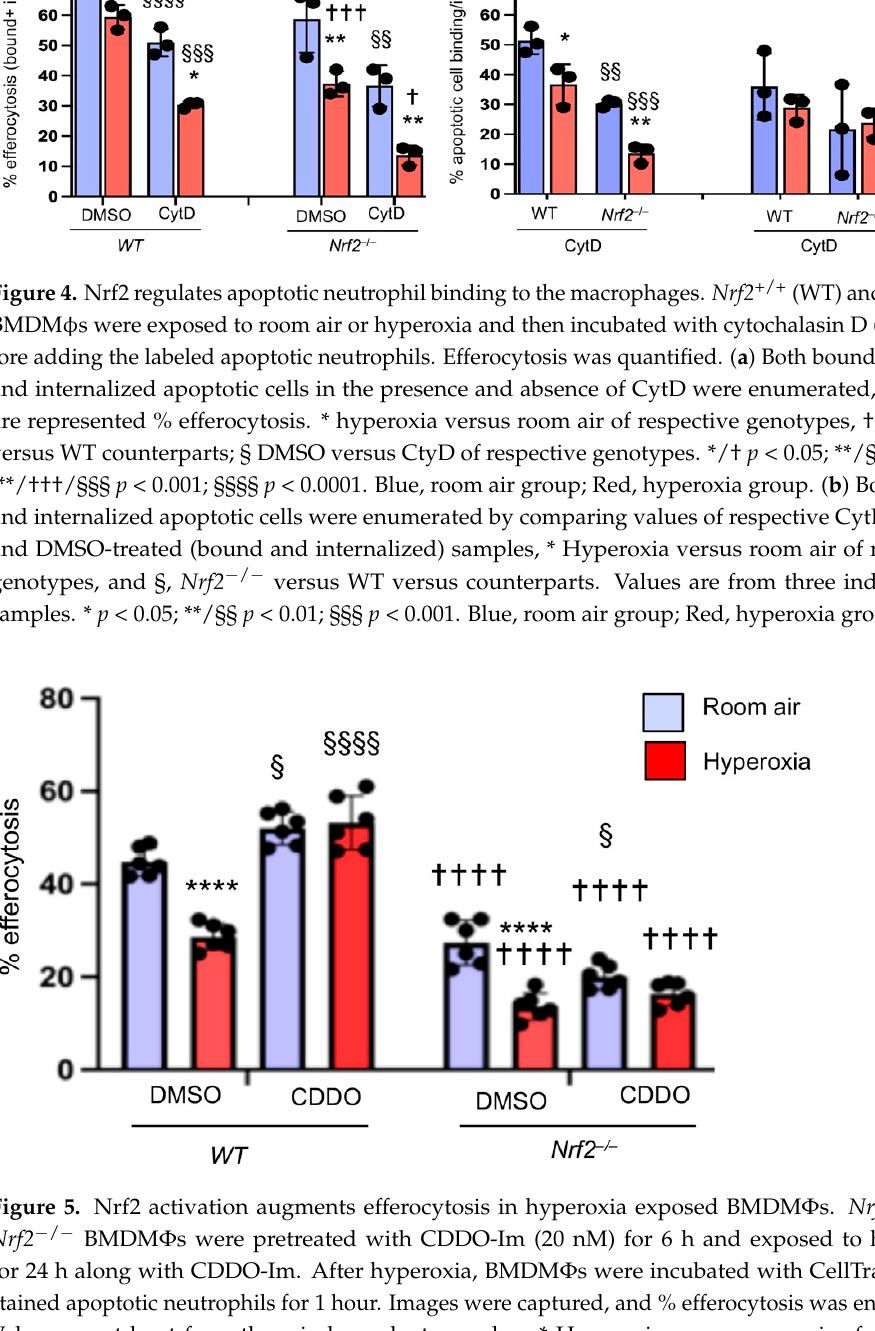
Figure 4. Nrf2 regulates apoptotic neutrophil binding to the macrophages. Nrf2 +/+ (WT) and Nrf2 − / − BMDM Ф s were exposed to room air or hyperoxia and then incubated with cytochalasin D (CtyD) before adding the labeled apoptotic neutrophils. Efferocytosis was quantified. ( a ) Both bound/at- tached and internalized apoptotic cells in the presence and absence of CytD were enumerated, and data are represented % efferocytosis. * hyperoxia versus room air of respective genotypes, †, Nrf2 − / − versus WT counterparts; § DMSO versus CtyD of respective genotypes. */† p < 0.05; **/§§ p < 0.01; ***/†††/§§§ p < 0.001; §§§§ p < 0.0001. Blue, room air group; Red, hyperoxia group. ( b ) Both bound and internalized apoptotic cells were enumerated by comparing values of respective CytD (bound) and DMSO-treated (bound and internalized) samples, * Hyperoxia versus room air of respective genotypes, and §, Nrf2 − / − versus WT versus counterparts. Values are from three independent sam- ples. * p < 0.05; **/§§ p < 0.01; §§§ p < 0.001. Blue, room air group; Red, hyperoxia group.